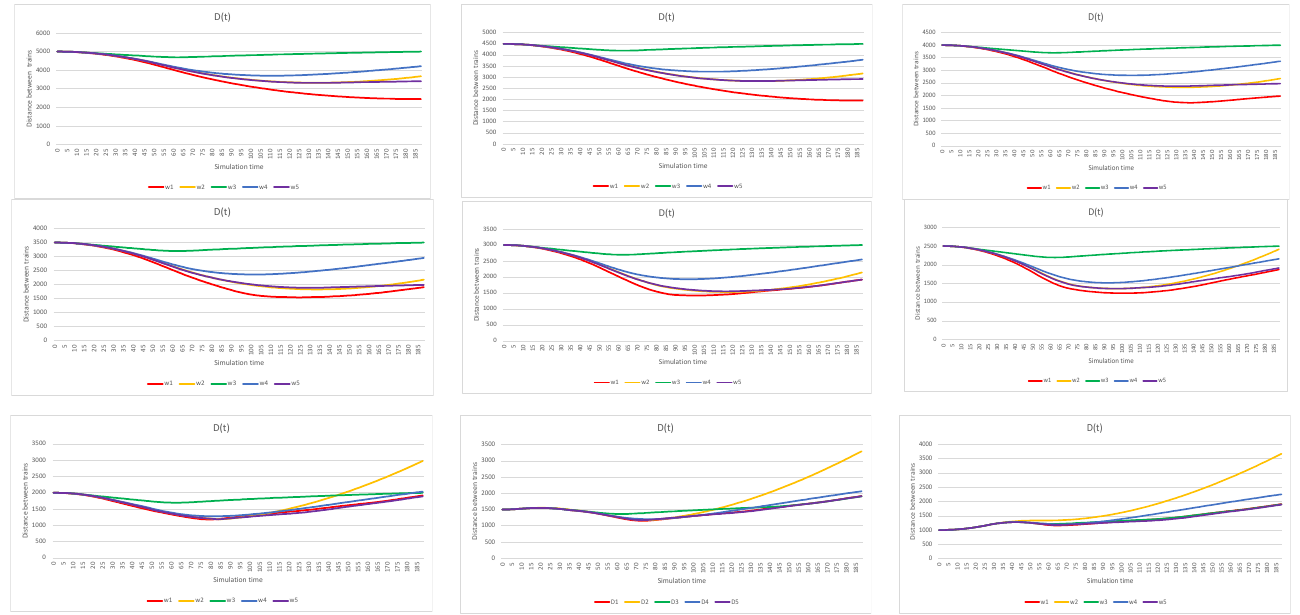
Figure 14. Summary of distance curves D ( t ) for D 0 = 5000, 4500, 4000, 3500, 3000, 2500, 2000, 1500, 1000 (m) in simulation for context 2.